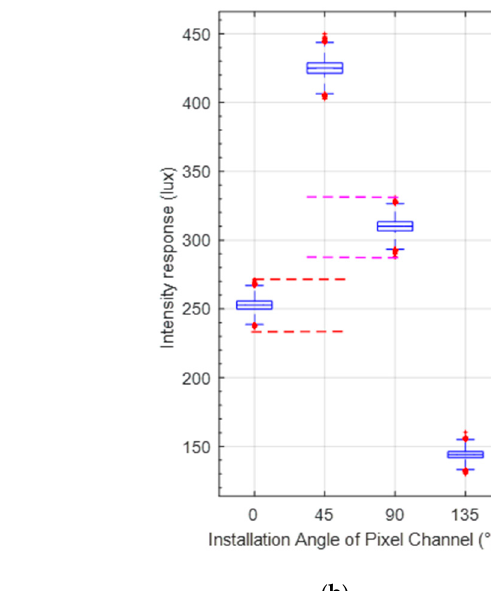
Figure 6. Distribution of light-intensity response of every pixel in single image ( a ) before calibration and ( b ) after calibration.